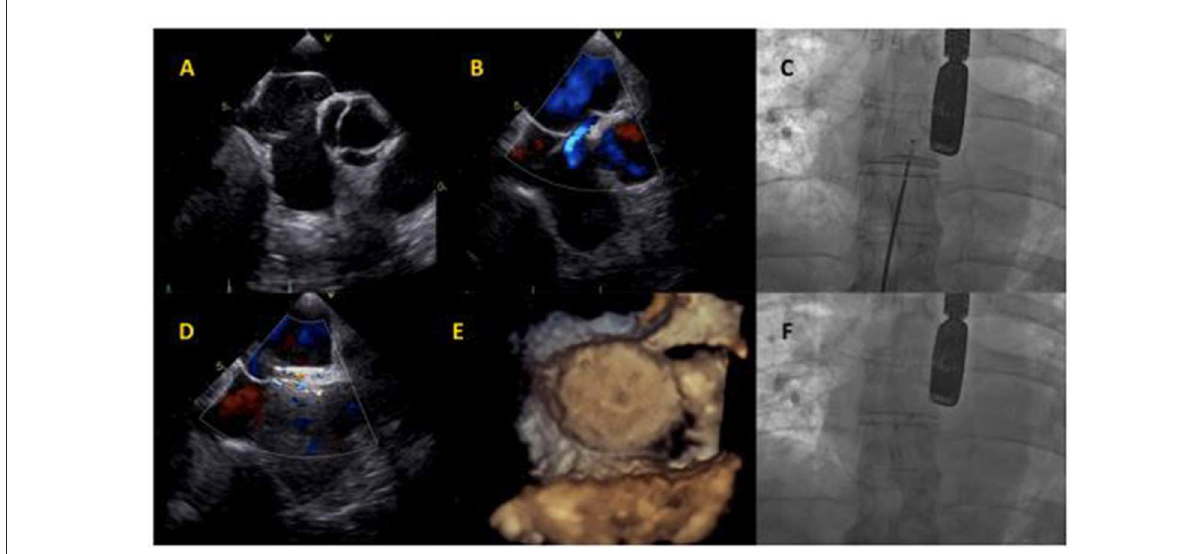
FIGURE2 Cocoon PFO Occluder implantation. (A) Baseline transesophageal echocardiography showing atrial septum aneurysm and Chiari network. (B) Baseline interatrial shunt. (C) Cocoon PFO Occluder positioning at fluoroscopy. (D) Intraprocedural transesophageal echocardiography, showing minimal intra-device shunt. (E) Device assessment with 3D-echocardiography imaging. (F) Final device release at